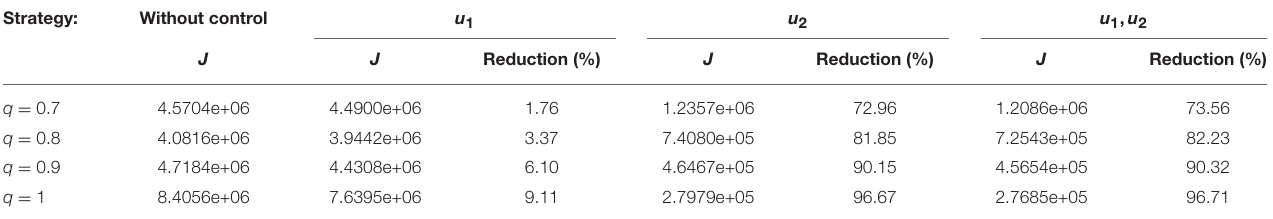
TABLE 2 | Values of the cost functional J and reduction in J